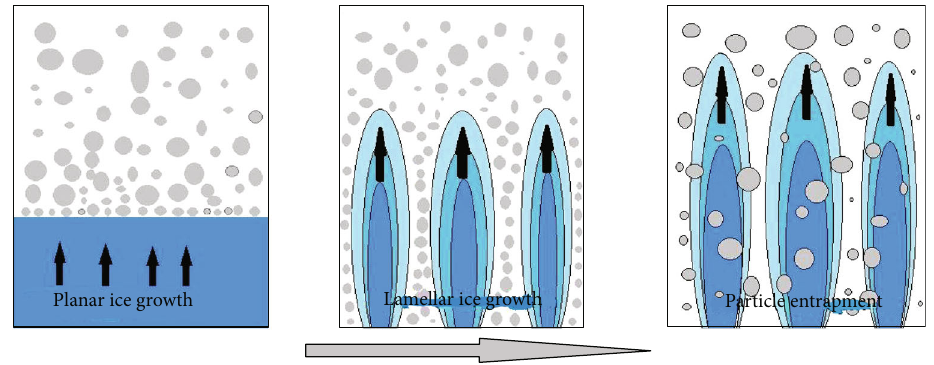
Figure 1: Solidi fi cation in freeze casting [14].